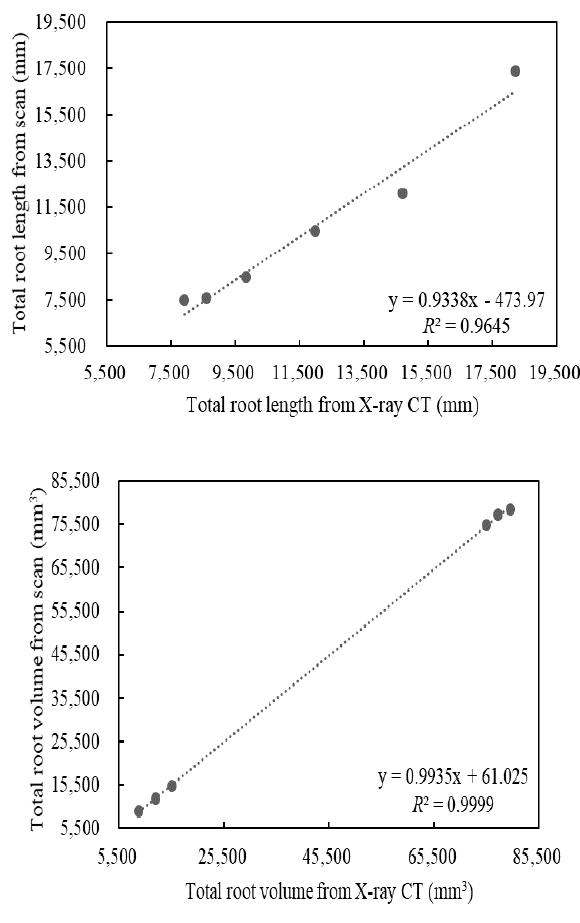
Figure 6. Comparisons between total root length and total root volume determined by X-ray CT and root system scanning after water washing.